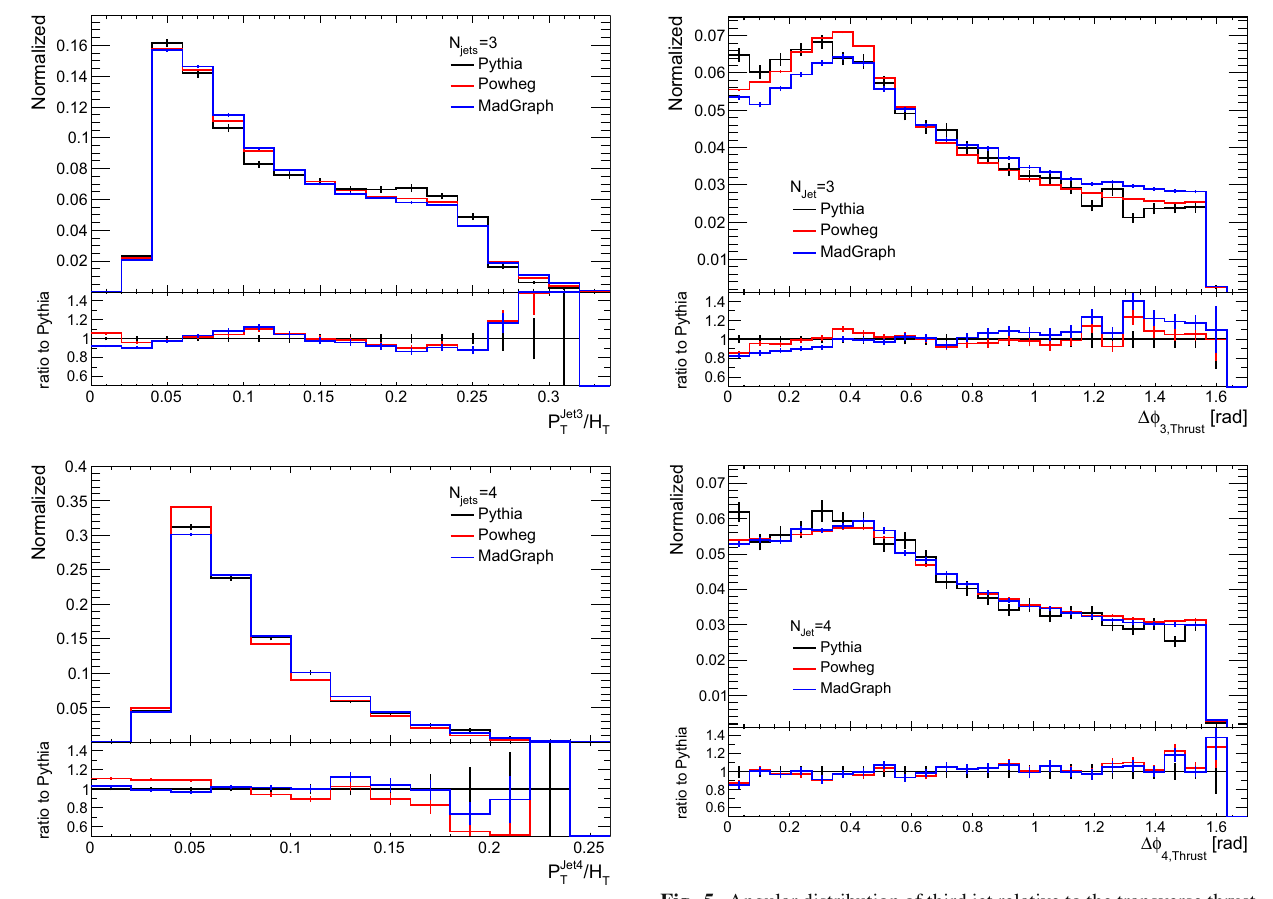
Fig. 4 The fraction of the transverse momenta carried out by third jet ( 3 ) T ( p ) in 3-jets events (top), and by the fourth jet ( p H T (bottom). All entries are for events satisfying H T > 1 TeV